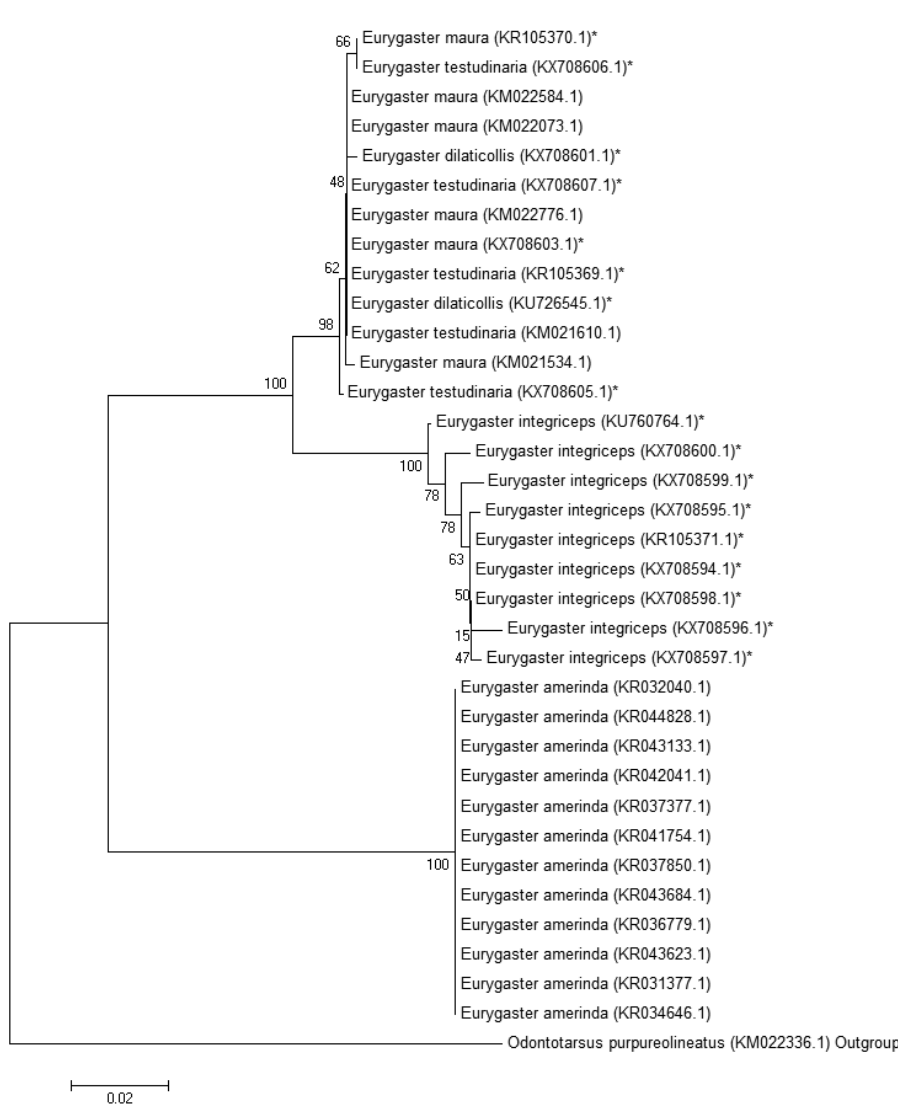
Figure 8. Neighbor joining analysis of COI gene sequences from Eurygaster species. * - sequences ob- tained in this